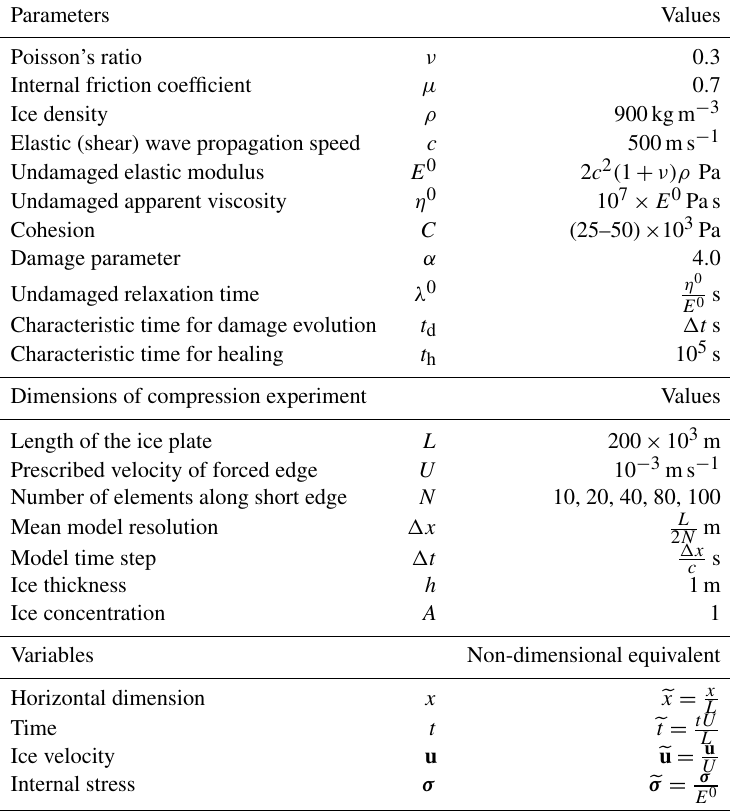
Table 1. Model variables, parameters and domain dimensions for the uniaxial compression